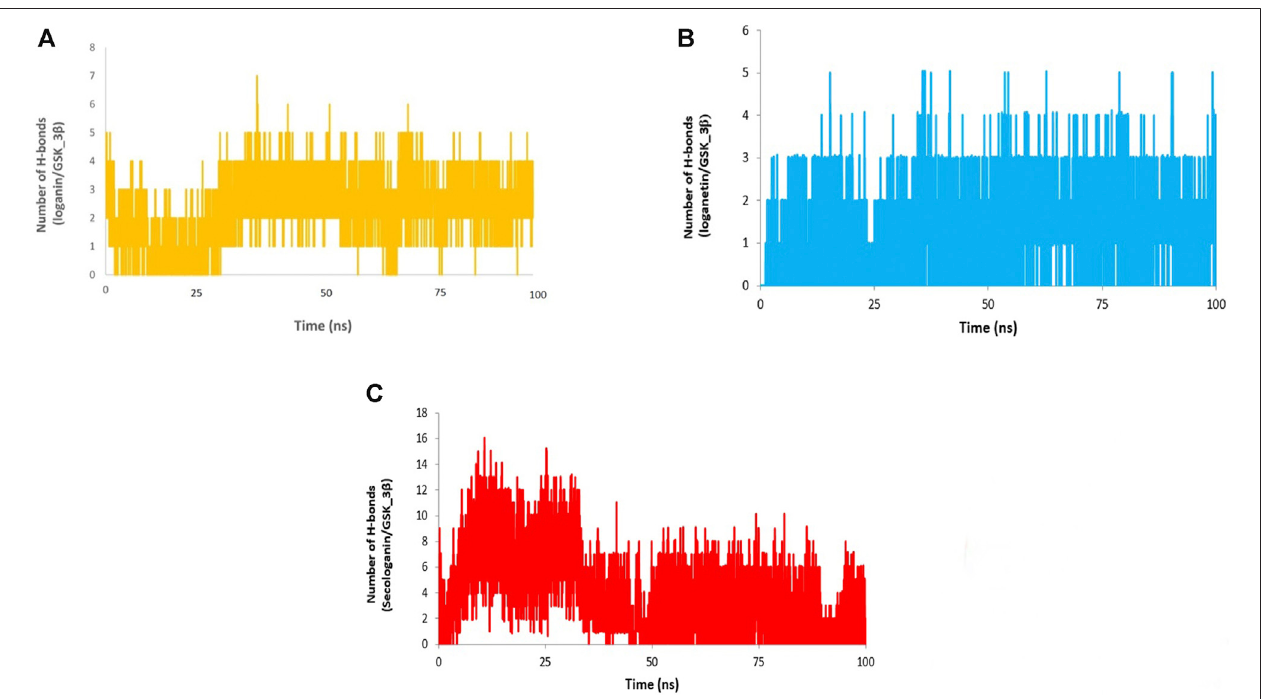
FIGURE 12 | H-bond analysis (A) loganin, (B) loganetin, and (C) secologanin.